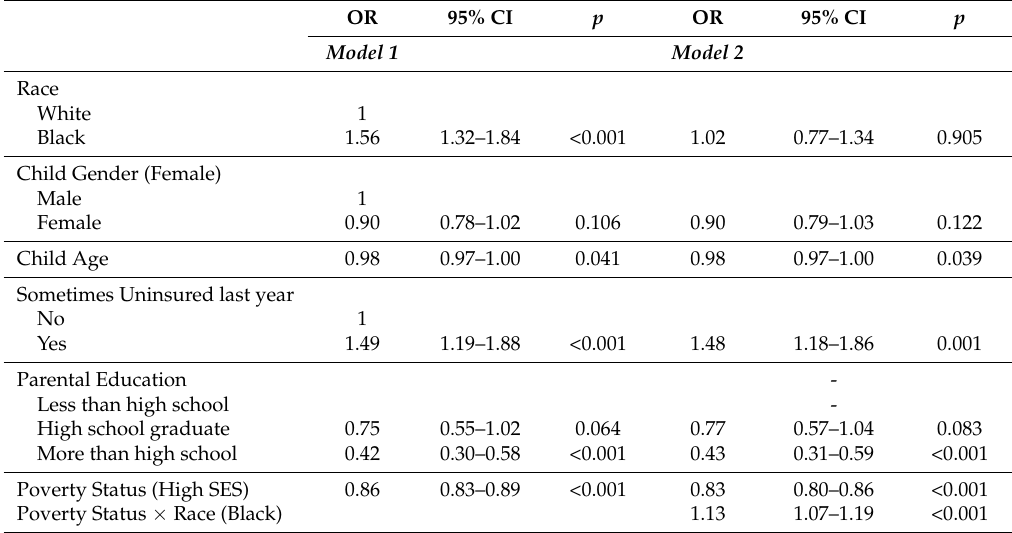
Table 3. Summary of logistic regression models in the pooled sample.